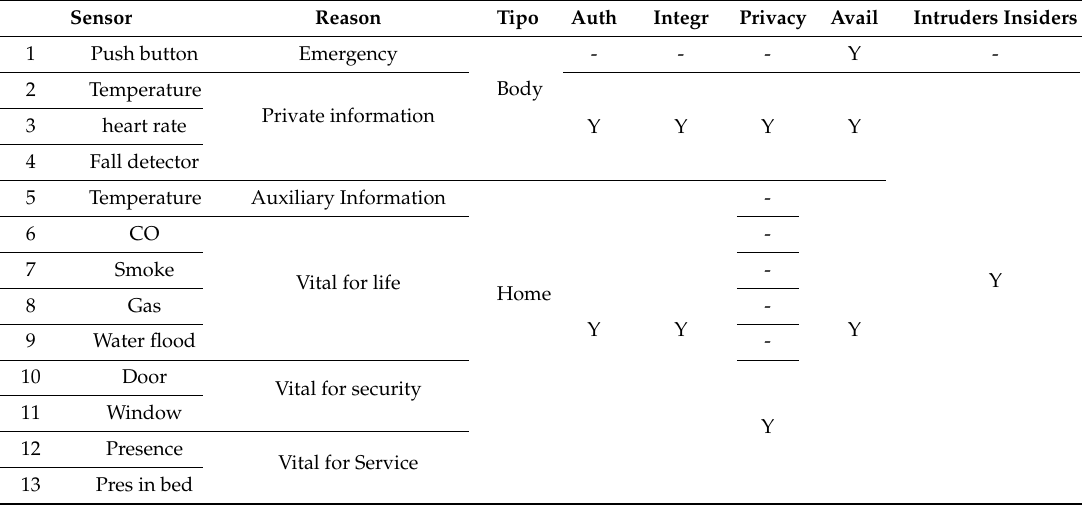
Table 6. Data protection over data sets.